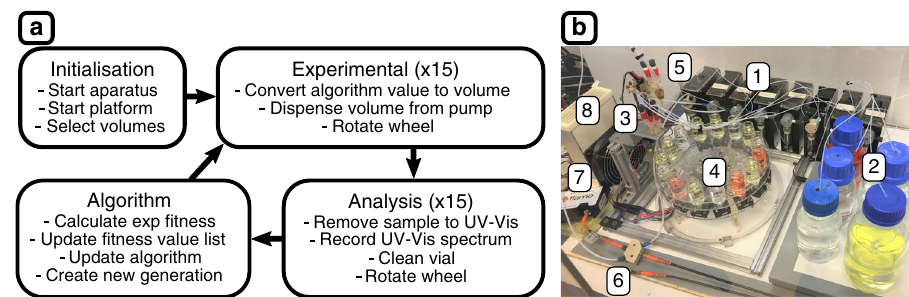
Fig. 3 General operating outline and top view of the robot for the controlled synthesis of AuNPs. a Summary of the initialisation of the platform, the experimental and analysis sequences and the algorithm operations for a single generation of reactions. b The platform consisting of (1) tri-continent C3000 syringe pumps, (2) reagent bottles on stirring plate, (3) dispensing stage, (4) geneva wheel with vial tray, (5) sample extraction module, (6) fl ow cell/optics, (7) ocean optics fl ame UV-Vis spectrometer and (8) heating